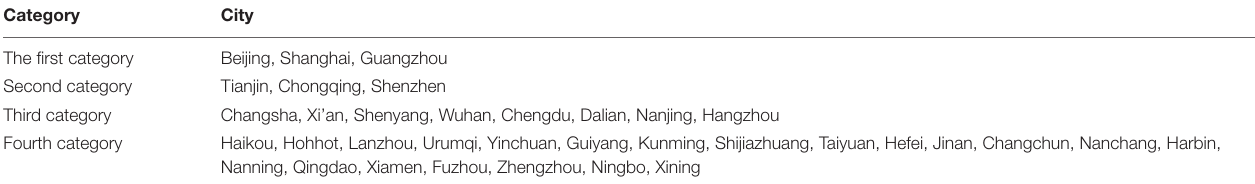
TABLE 4 | Classification and summary of the social development of 35 large and medium-sized cities in the 2011–2015 period. Category